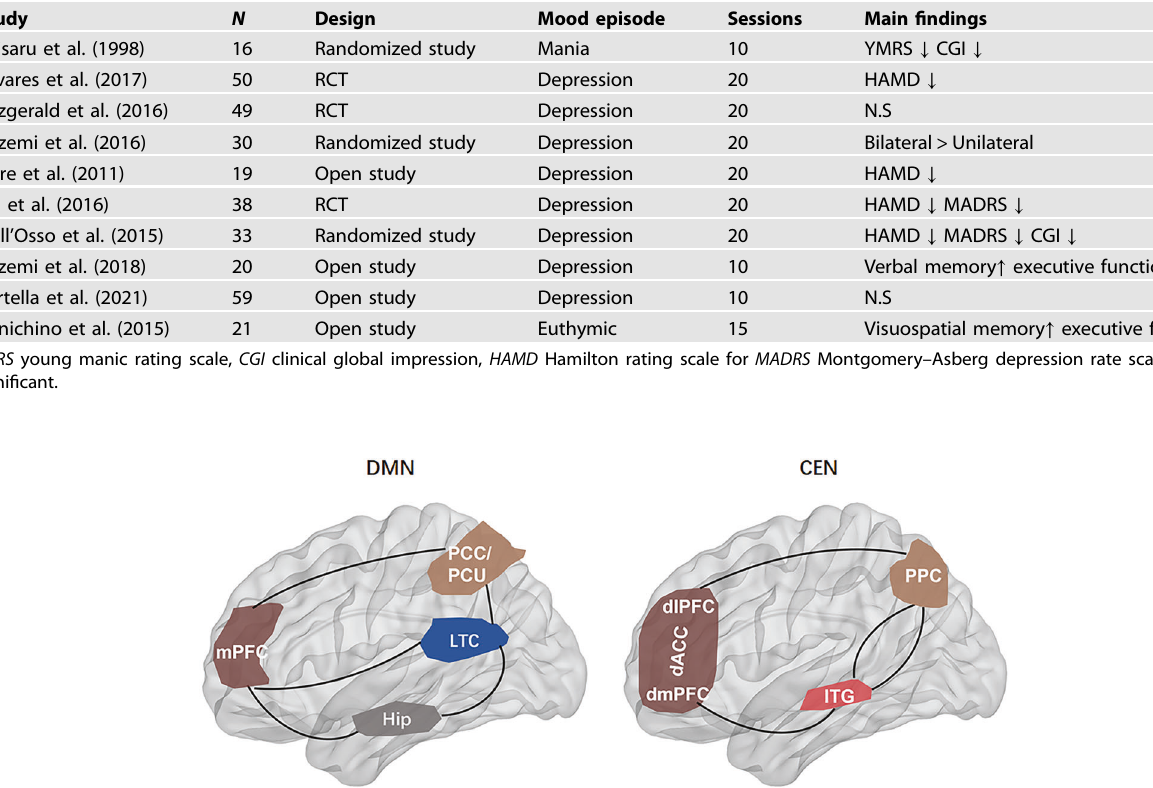
dmPFC dorsomedial prefrontal cortex, PPC posterior parietal cortex, ITG inferior temporal